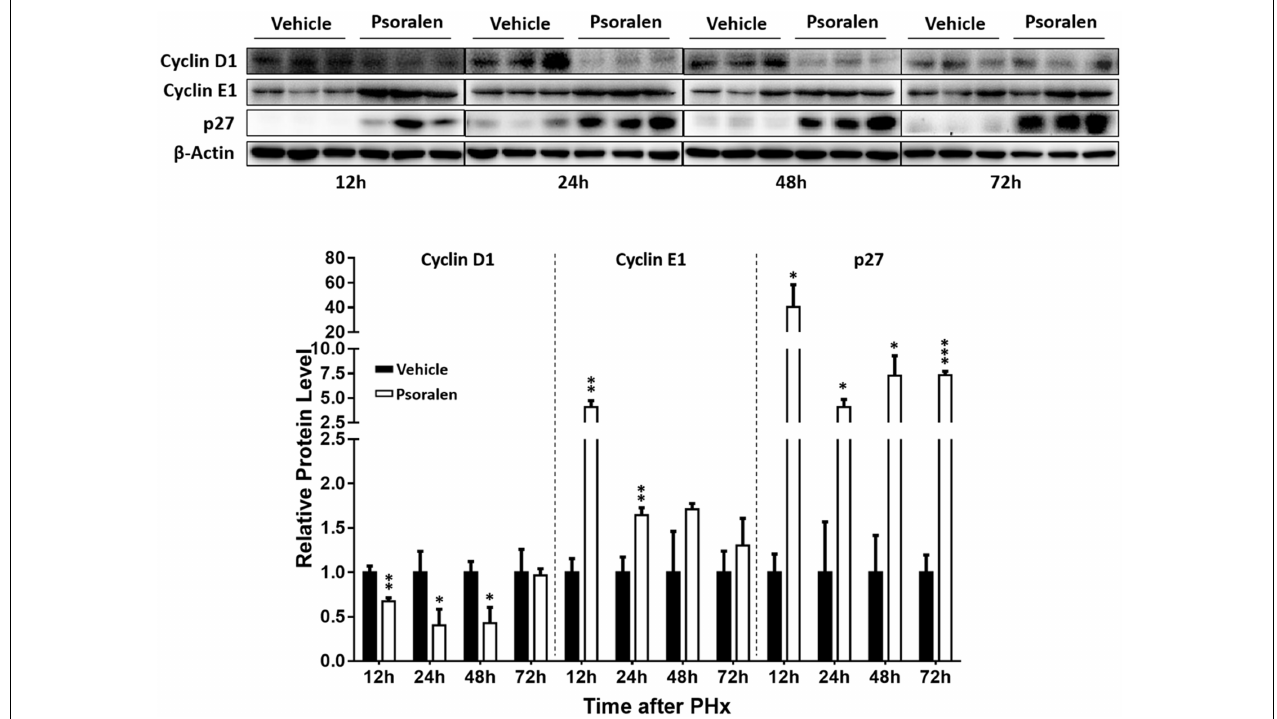
FIGURE 6 | Psoralen decreased cyclin D1 and increased cyclin E1 and p27 protein levels in PHx mice. C57BL/6 mice were subjected to PHx and treated with 200 mg/kg of psoralen or 0.5% CMC-Na. Upper panel: representative immunoblots for the protein levels of cyclin D1, cyclin E1, and p27; lower panel: the relative protein levels were quantified and normalised to β -actin. Data are means ± SDs ( n = 6). ∗ p < 0.05, ∗∗ p < 0.01, ∗∗∗ p < 0.001 versus vehicle